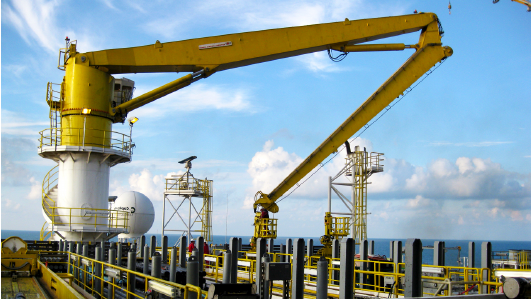
Figure 2: Knuckle Boom Crane example provided by National Oilwell Varco. c